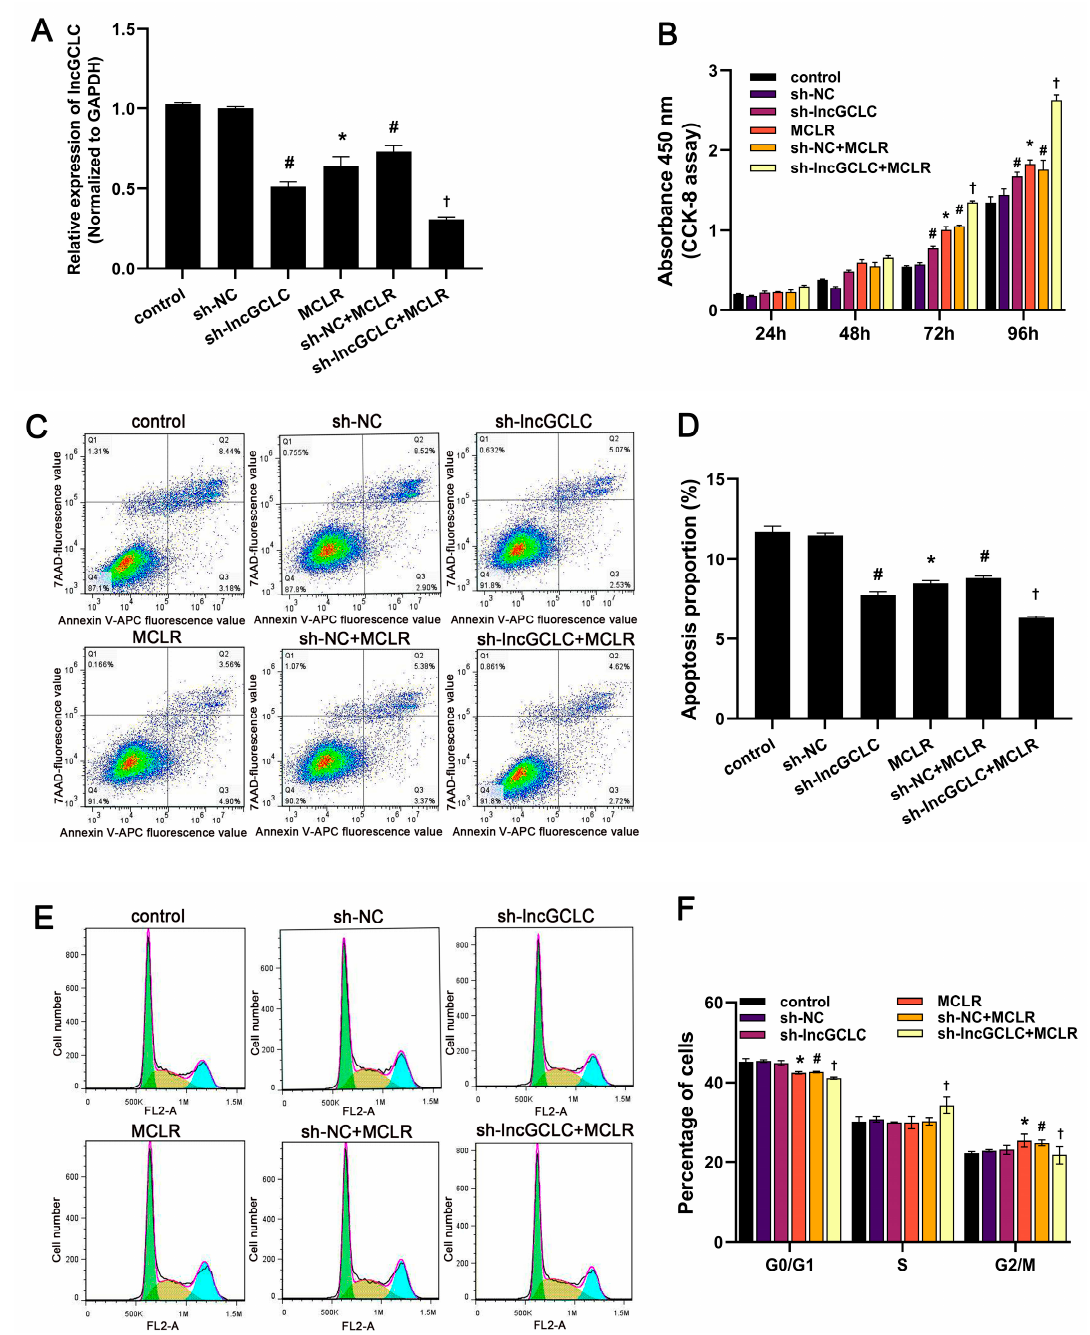
Figure 2. Knockdown of lncGCLC promoted the proliferation of MCLR-treated WRL68 cells. Vector- or sh-lncGCLC-transfected cells were treated with or without 10 µ g/L of MCLR for 25 passages. ( A ) The expression of lncGCLC was detected using qRT-PCR. ( B ) Cell proliferation activity was detected by CCK-8. ( C ) Cell apoptosis was analyzed using flow cytometry. ( D ) Apoptosis rate in each group. ( E ) The percentage distribution of cells in the G1/G0, S, and G2/M phases of the cell cycle was determined by flow cytometry. ( F ) Cell cycle distribution quantification. Data are presented as the means ± SD of three independent experiments in each group. * p < 0.05 compared with the control group; # p < 0.05 compared with the sh-NC group; † p < 0.05 compared with the sh-NC + MCLR